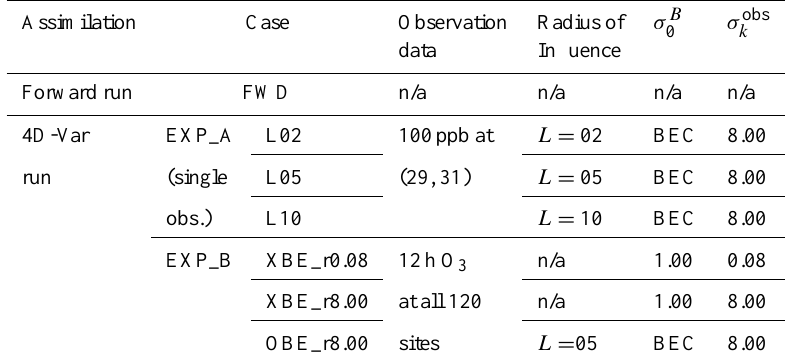
Figure 4. Diurnal variations of horizontal distribution of ozone (contour) and wind (vector) at 3-hour interval starting from 06:00LST on 5 August. Table 3. Experimental design for the idealized background error covariance test. The FWD case is conducted and the results are compared with that of the 4D-Var